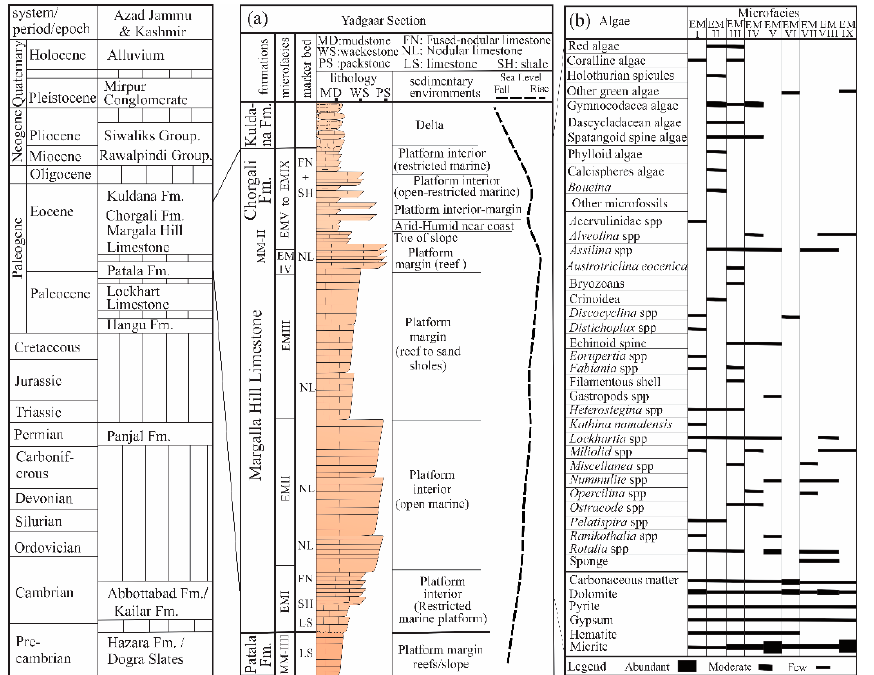
Figure 2. ( a ) Litholog of the Early–Middle Eocene carbonate rocks from the Yadgaar Section; ( b ) microfossils identified from the studied section. MD, Mudstone; FN, Fused nodular limestone; WS, Wackestone; NL, Nodular limestone; PS, Packstone; LS, Limestone; SH, Shales.